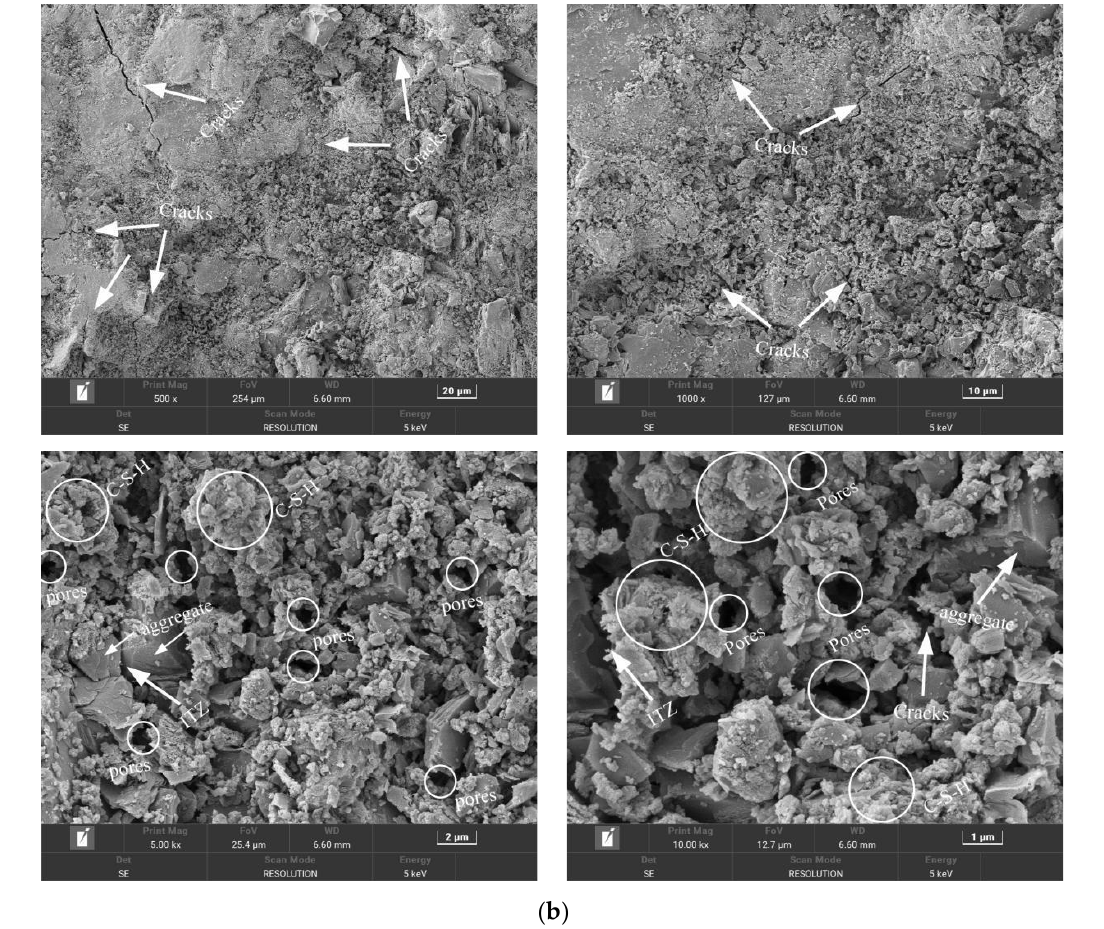
Figure 10. Microstructure of recycled aggregate concrete before and after freeze – thaw damage. ( a ) Freeze – thaw cycle 0 times; ( b ) Freeze – thaw cycle 150 times.